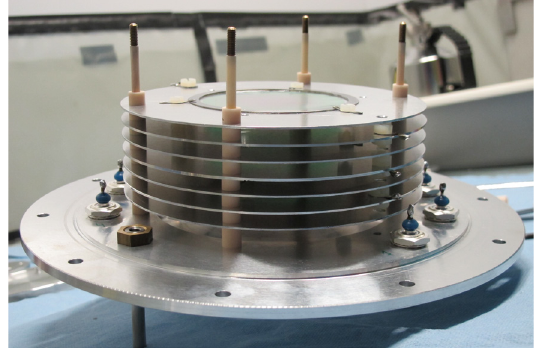
Fig. 4. Multi-layer 235 U based fluence